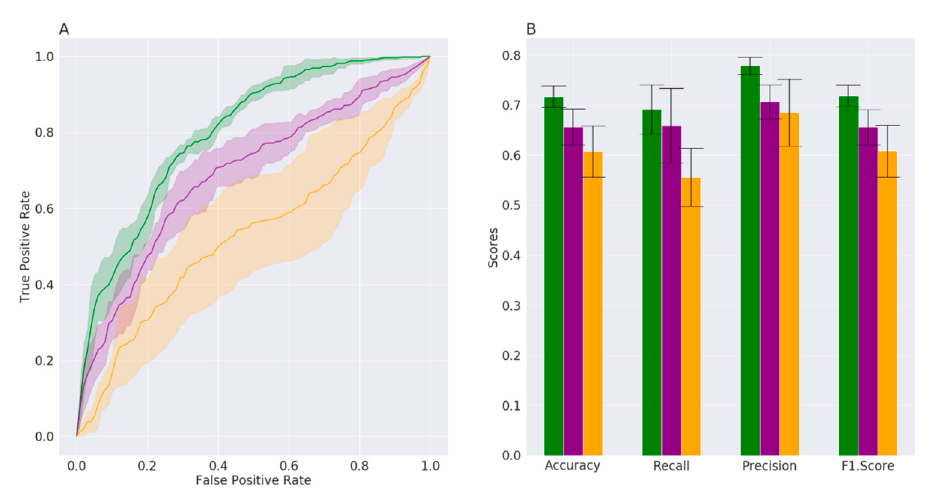
Figure 1. ( A ) Average ROC curves (over 5 folds) with confidence intervals and ( B ) prediction performance metrics with the relative margin of error. The results for random forests are reported in green, for neural networks in purple and for support vector machines in orange, respectively.